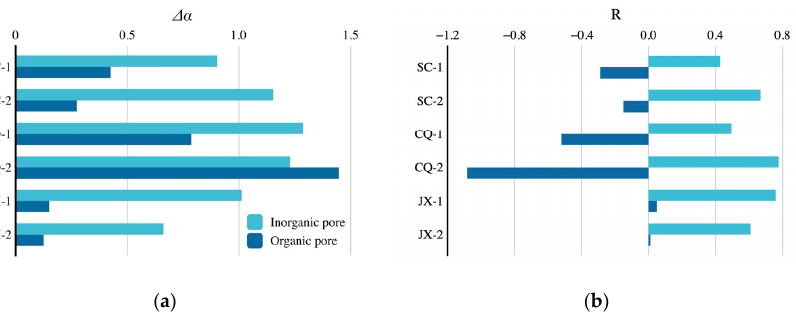
Figure 7. Comparison of characteristic parameters from multifractal spectrums between organic and inorganic pores: ( a ) ∆𝛼 , ( b ) 𝑅 .